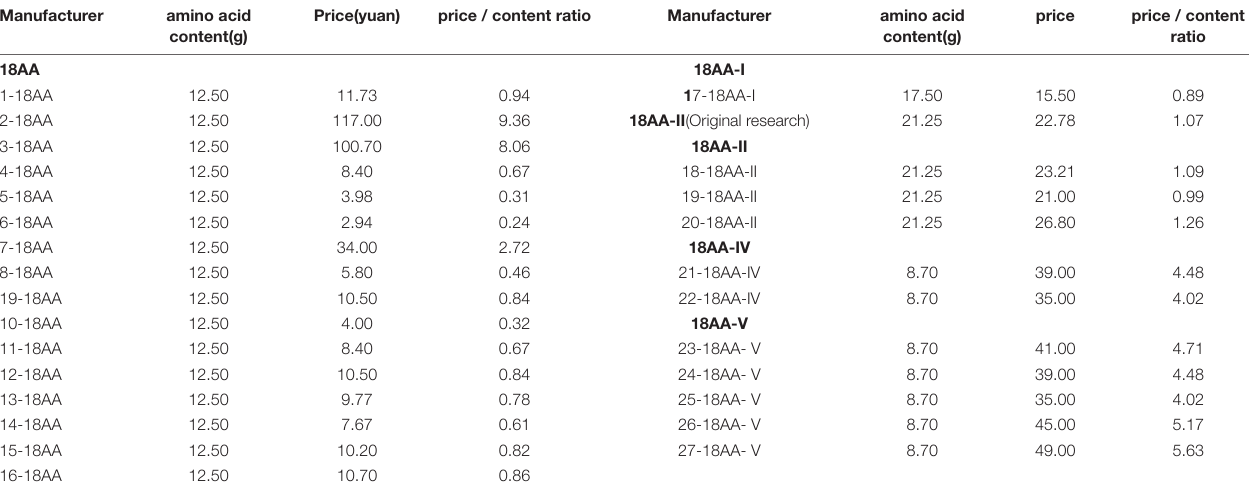
TABLE 6 | The amino acid content (g), price (yuan), and each bottle of amino acid (250 ml) from 28 manufacturers. Manufacturer amino acid